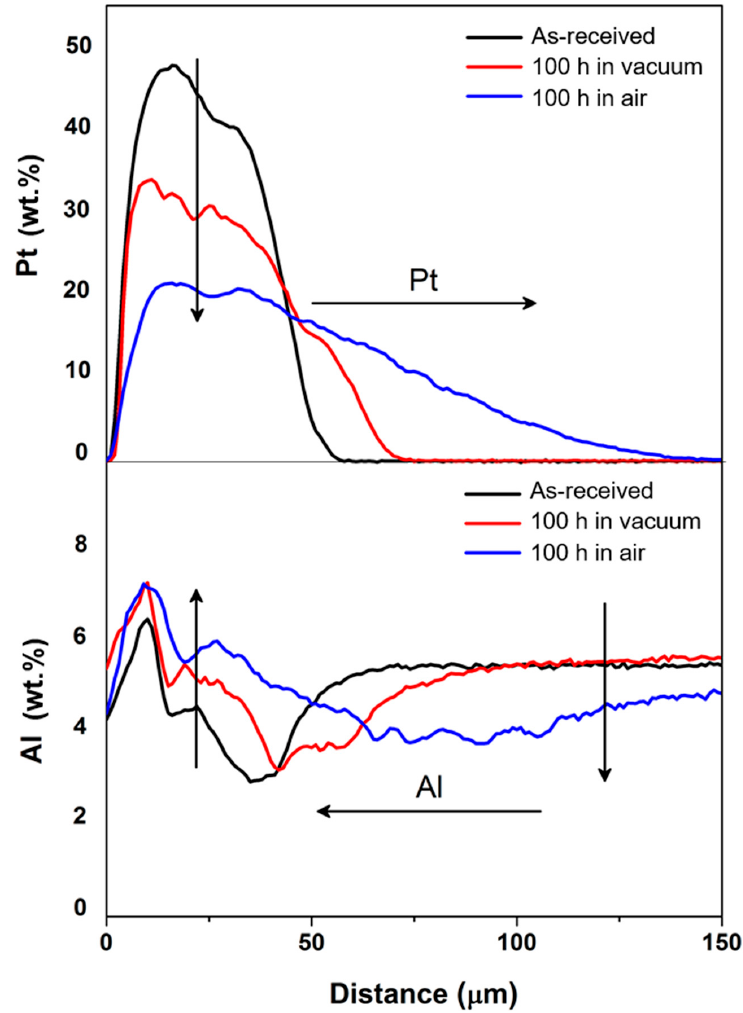
Figure 6. Pt and Al concentrations on the cross-sections of Pt-diffused γ / γ ’ bond coat.